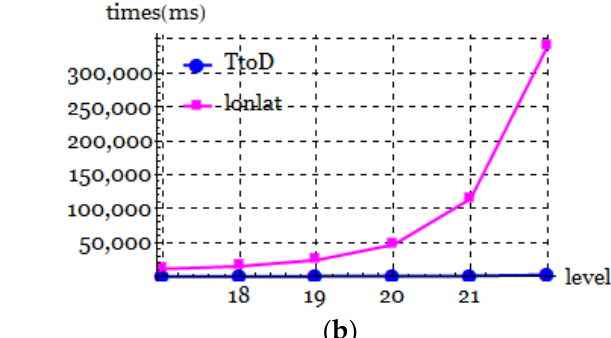
Figure 11. Efficiency comparison diagram between GtoG and longitude–latitude method expressing discrete lines. ( a ) Efficiency comparison curve between HtoTcode and longitude–latitude